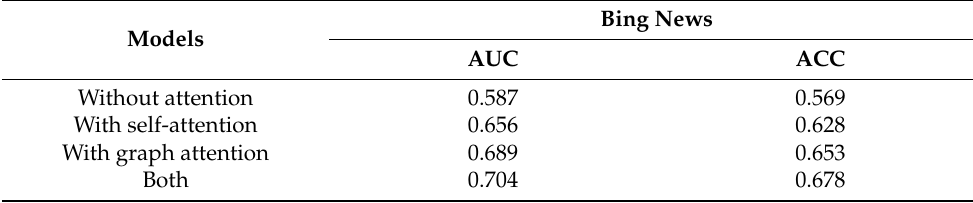
Table 4. Effectiveness of different attention